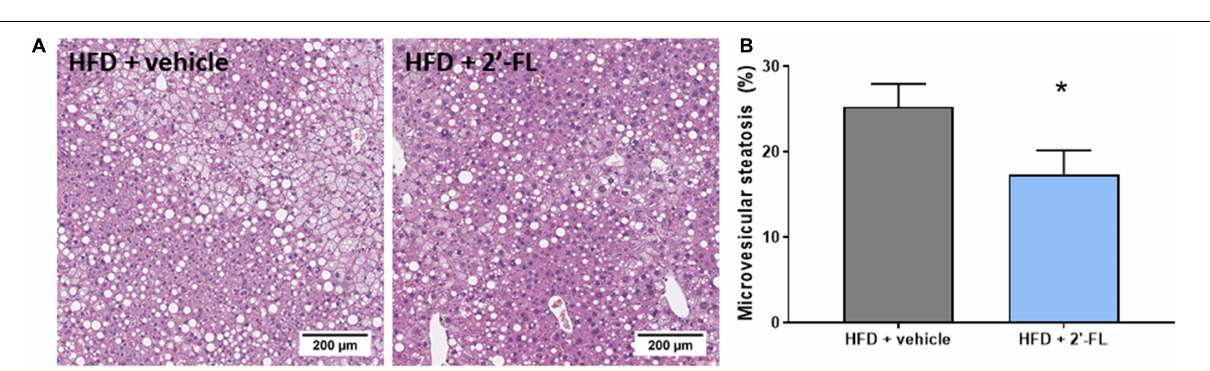
FIGURE 3 | Human milk oligosaccharide 2 (cid:48) -FL reduced the accumulation of lipids in small lipid droplets referred to as microvesicular steatosis. (A) Representative images (B) percentage of hepatic cross-section affected with microvesicular steatosis. Data is from n = 18 mice per treatment group shown as mean ± SEM, * p <